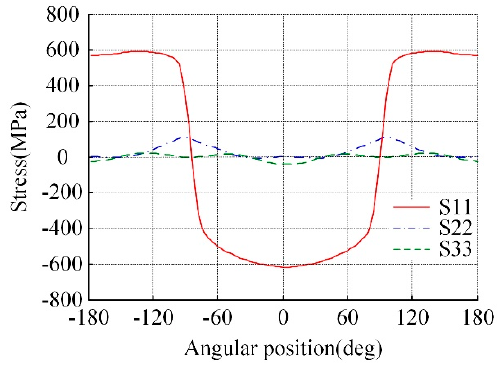
Figure 13. The stress of the outer surface of the pipe in different directions.